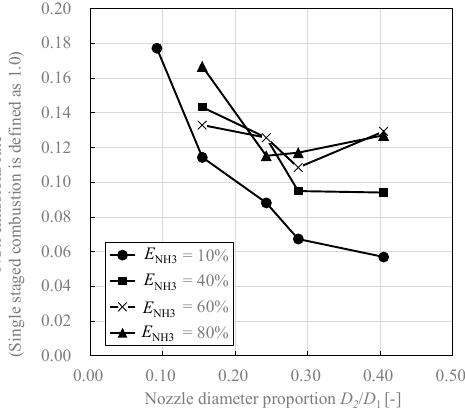
Figure 7. Comparison of NOx emissions rates for different D 2 / D 1 . Input = 11.63 kW, λ total = 1.2, L = 100 mm.